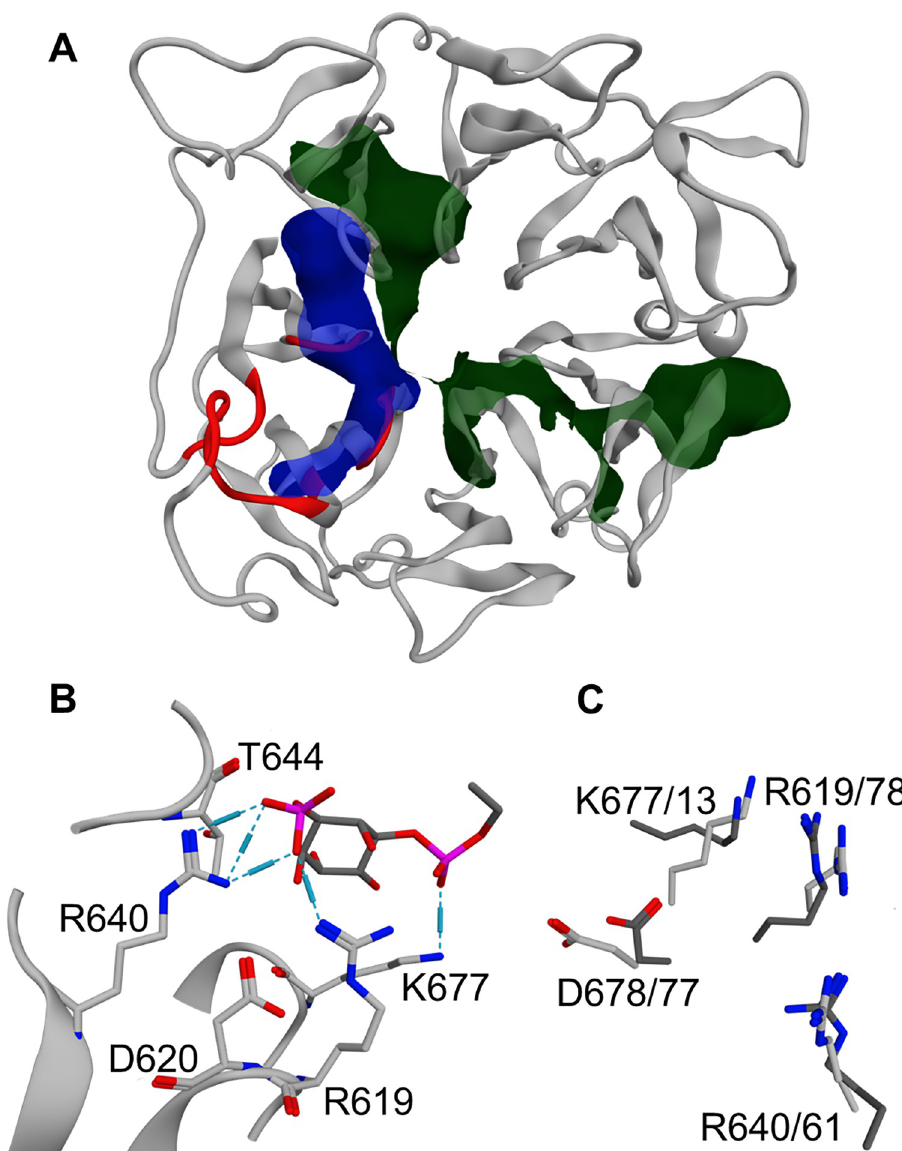
Fig 2. Identification of a putative PIP-binding site in Alsin RLD. ( A ) Visual rendering of the investigated binding pocket. The positive and hydrophobic surface patches are shown in blue and green, respectively, while residues forming the binding site are colored in red. ( B ) Binding pose of PI(3)P at the end of the dynamics, where interactions between two atoms are represented by dashed lines. The strength of an interaction is visually represented by the length of the cylinder. ( C ) Superimposition of RLD query residues (light grey) and the corresponding amino acids of the best hit found through ASSAM (dark grey). In the figure, residue numbers are reported according to the scheme N N hit